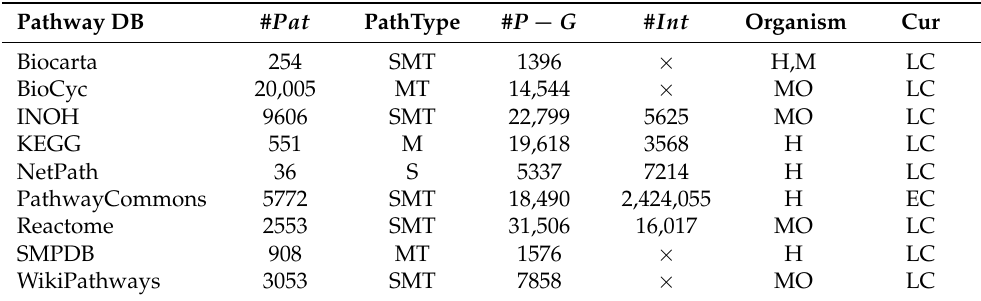
refers to the total number of memorized pathways for each database; PathType provides infromation about the handled pathway type; # P − G provides information about the total number of covered proteins/genes for each database; # Int is the total number of interactions available in each database; organism provides information on the pathway origin organism; Cur specifies how pathway data are handled in each databases. In the table, SMT is the contraction of Signaling, Metabolic and Transduction pathways. MO indicates Multi-Organisms. H is short for Human. LC and EC are short for Literature and Electronic